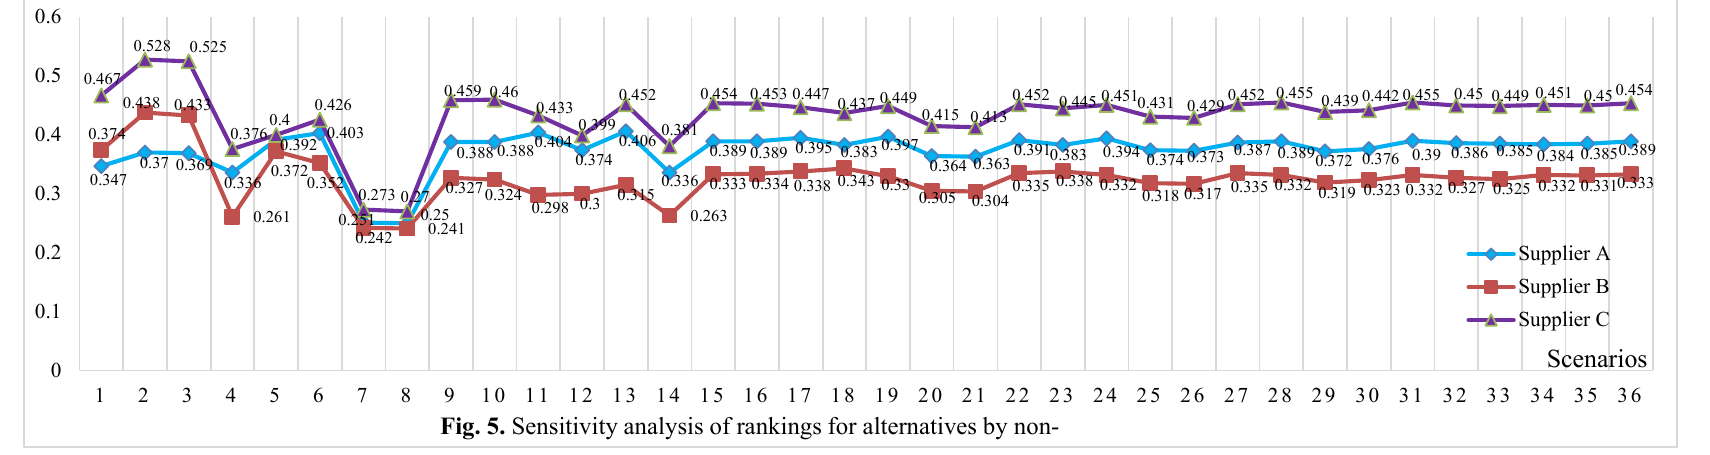
Fig. 5. Sensitivity analysis of rankings for alternatives by non-